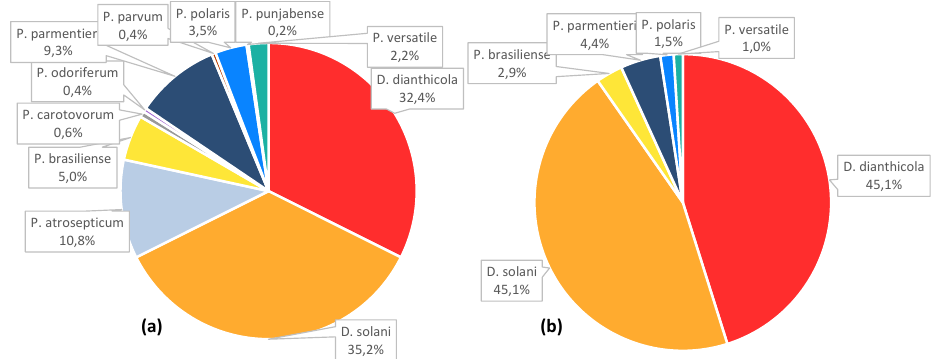
Figure 1. Species assignation. The gapA sequence was used for species assignation: ( a ) 463 isolates collected from 16 potato fields, which were rejected for seed tuber production because of blackleg symptoms, and ( b ) 206 isolates collected from seven parcels exhibiting blackleg symptoms after plantation of tuber seeds collected from symptomatic fields.